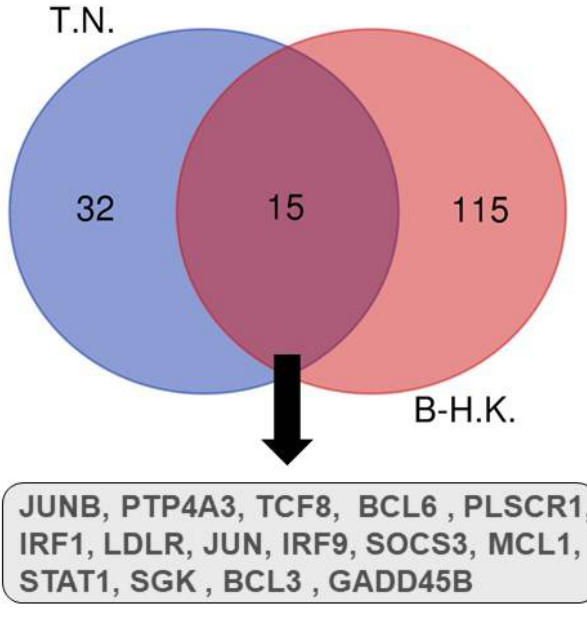
Figure 1. Venn diagrams of genes upregulated in MM cell lines after additional IL-6 stimulation. The MM-STAT3 signature contains 15 upregulated genes shared by studies of Brocke-Heidrich K, et al. (B-H.K., ref. [21]) and Tsuyama N (T.N., ref. [22]).